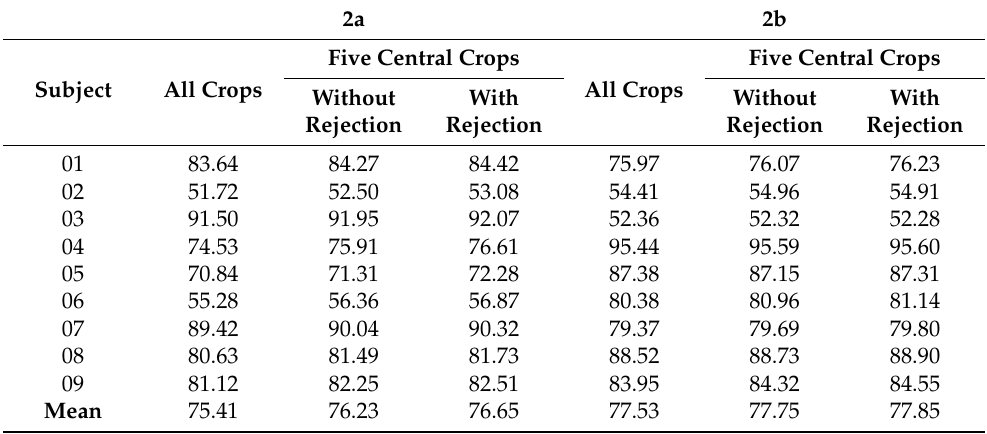
Table 8. Performance of SCBNN-MOPED (% accuracy) by using the selected crops for subject- specific